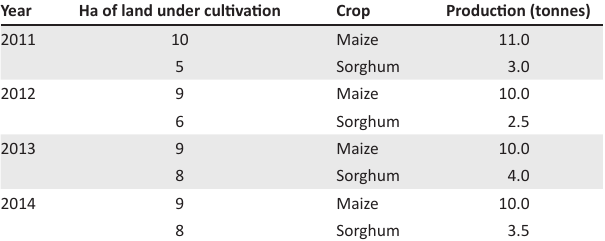
TABLE 1: Crop production of the Zunde raMambo scheme